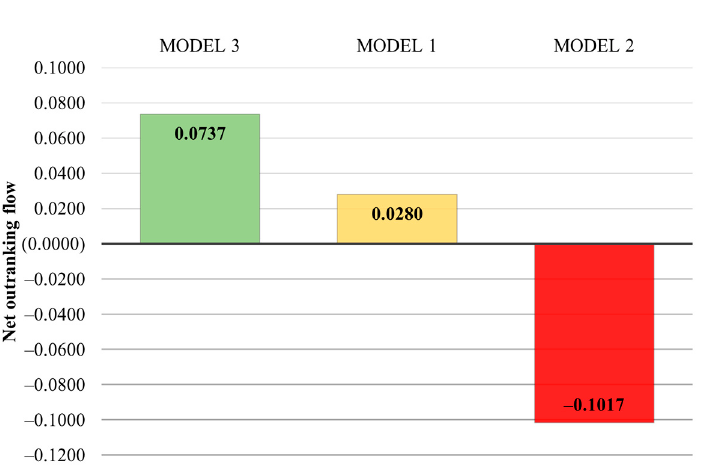
Figure 5. Final ranking of alternative solutions.